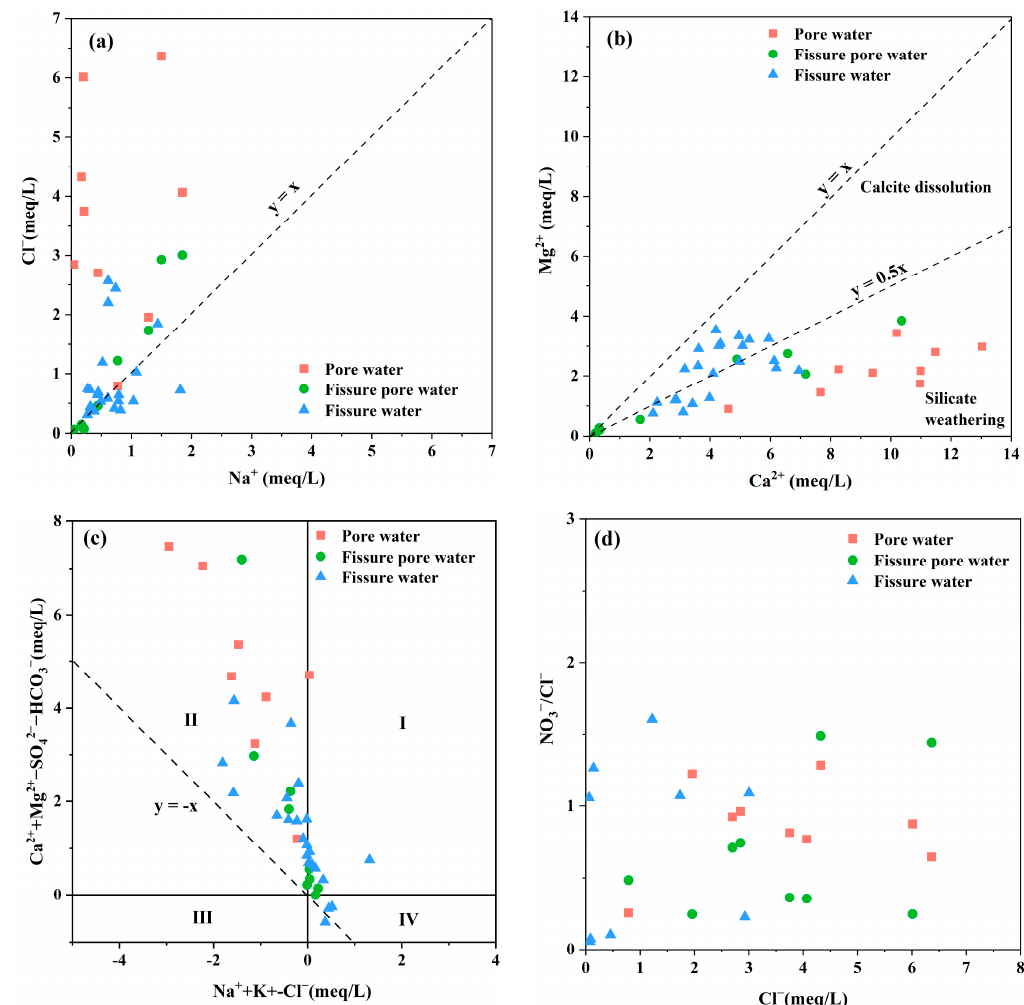
Figure 8. Analysis of the ion ratio in groundwater. ( a ) Cl − vs. Na + ; ( b ) Mg 2+ vs. Ca 2+ ; ( c ) Ca 2+